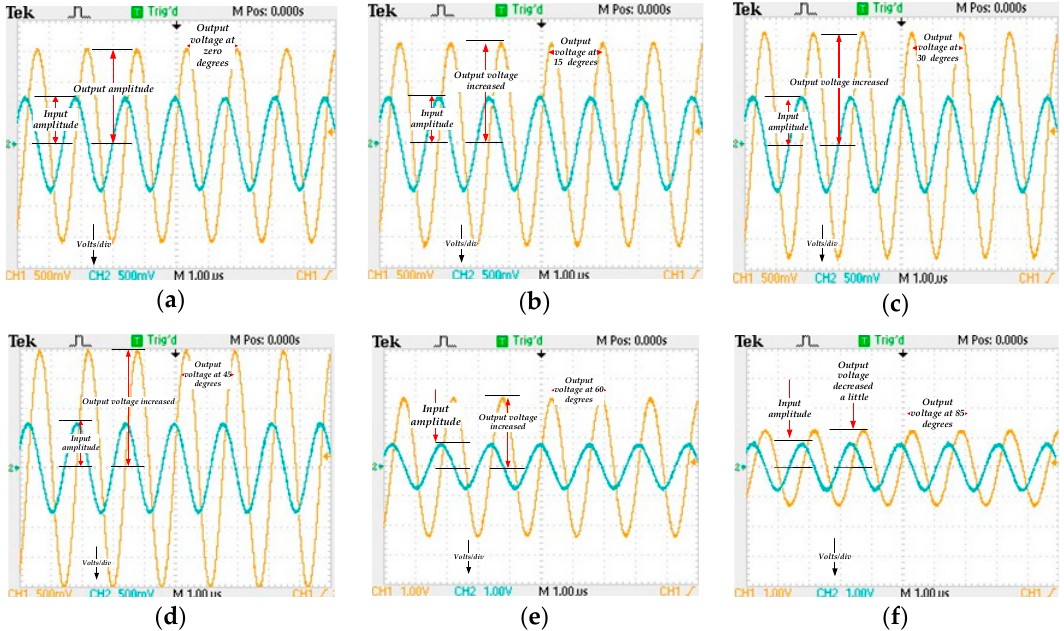
Figure 23. Input (blue) and output (orange) coil-to-coil voltages for the optimized model: ( a ) α = 0°; ( b ) α = 15°; ( c ) α = 30°; ( d ) α = 45°; ( e ) α = 60°; ( f ) α = 85°.